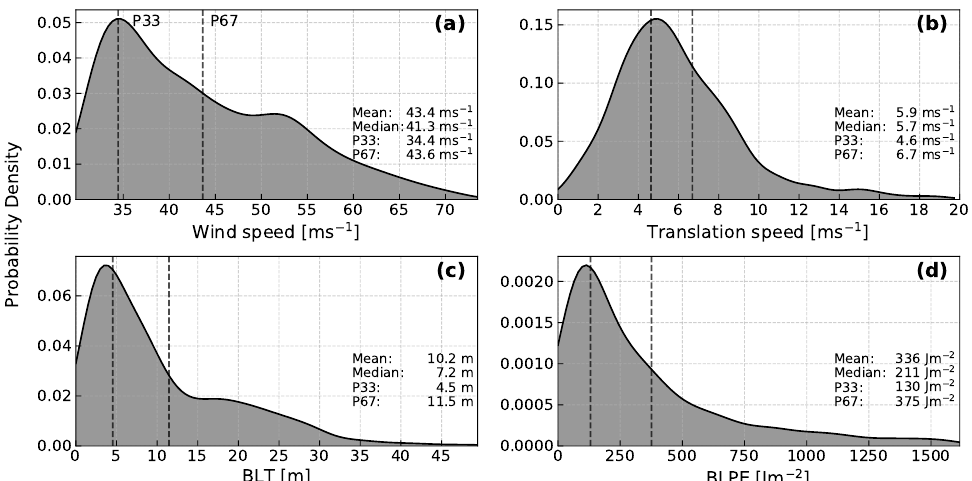
Figure 6. Probability Density Functions (PDF) for all hurricanes from 2002 to 2018 (both years included): ( a ) 10-min maximum sustained wind speed, ( b ) hurricanes translation speed, ( c ) associated value of barrier layer thickness (BLT) and ( d ) associated value of barrier layer potential energy (BLPE). P33 and P67 refer to percentile 33 and percentile 67, which are indicated by vertical dashed lines in each